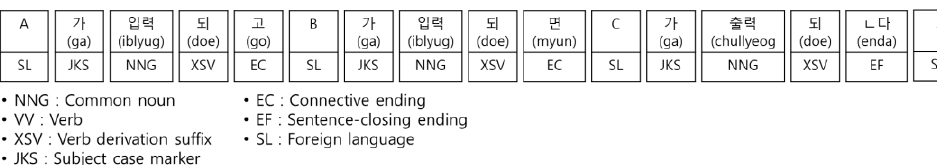
Figure 3. Analyzed morphemes of the sentence.